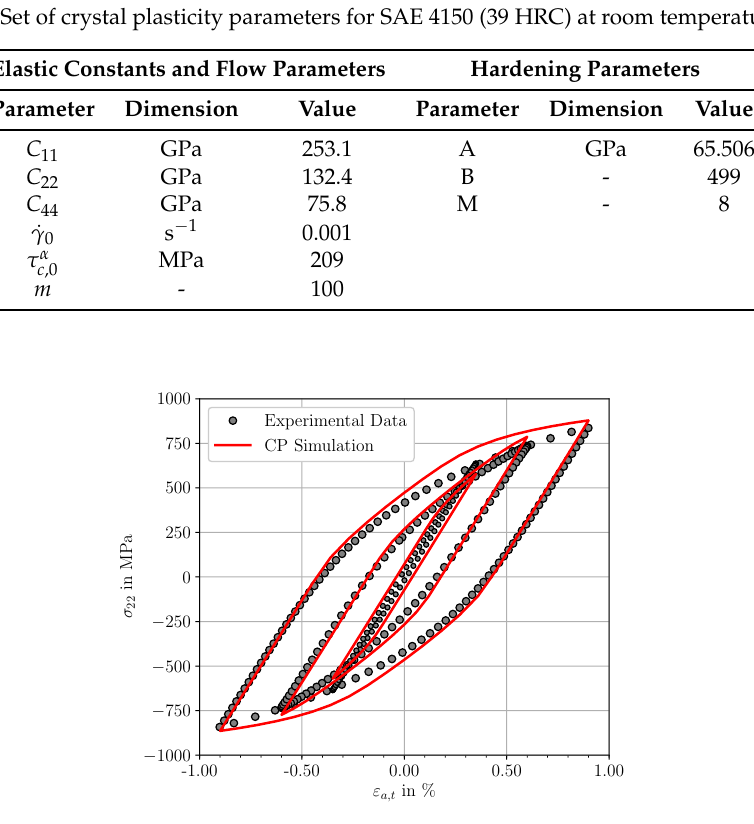
Figure 6. Stabilised cyclic stress-strain hystereses extracted at half-life of the LCF-experiments (grey markers) and the calibrated hystereses using the proposed crystal plasticity model and the corresponding parameter set (red